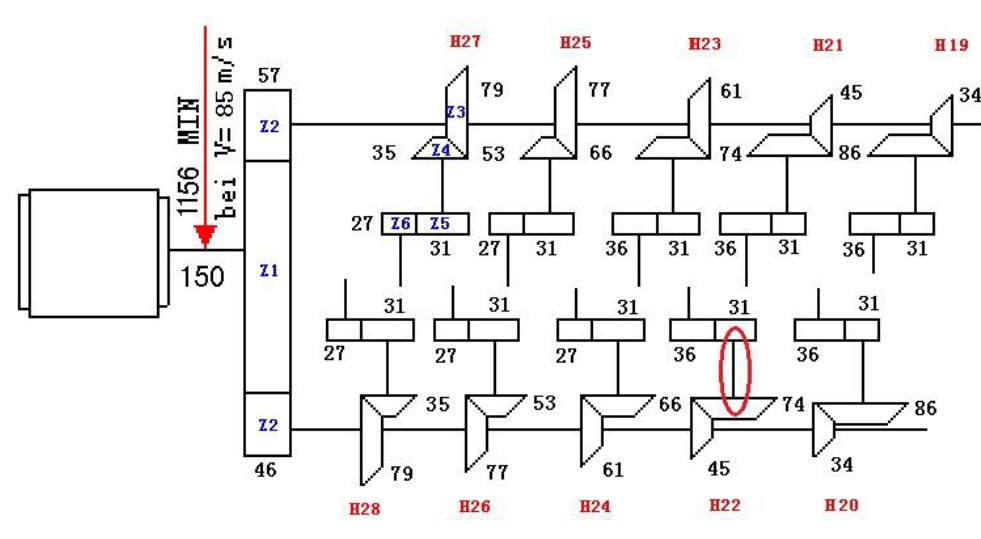
Figure 16. Driving chain of gearbox.